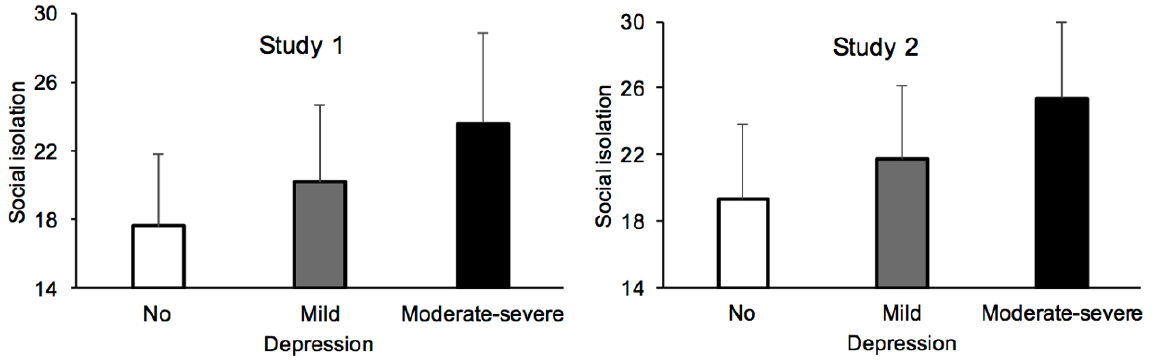
Figure 2. Feeling of social isolation as a function of severity of depressive symptoms in Study 1 and Study 2. For all participants, affiliation needs increased significantly during the lockdown as compared to before, F(1, 1123) = 131.68, p < 0.0001, η 2 p =.11. There was nevertheless little evidence that depressed participants sought more contact through social media than the other participants, F(2, 1123) = 10.74, p < 0.0001, η 2 p =.019, especially during the lockdown period, as suggested by the non-significant interaction between depression and lockdown, F(2, 1123) = 0.22, p =